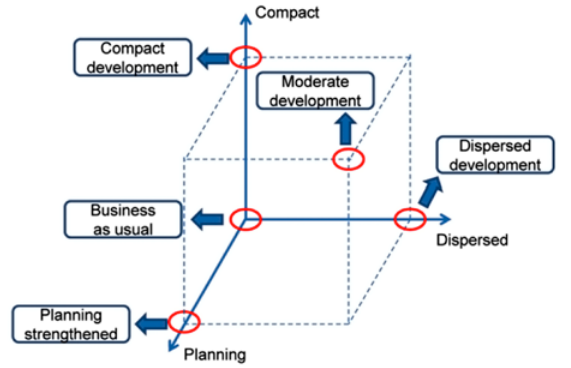
Fig. 4. Different development